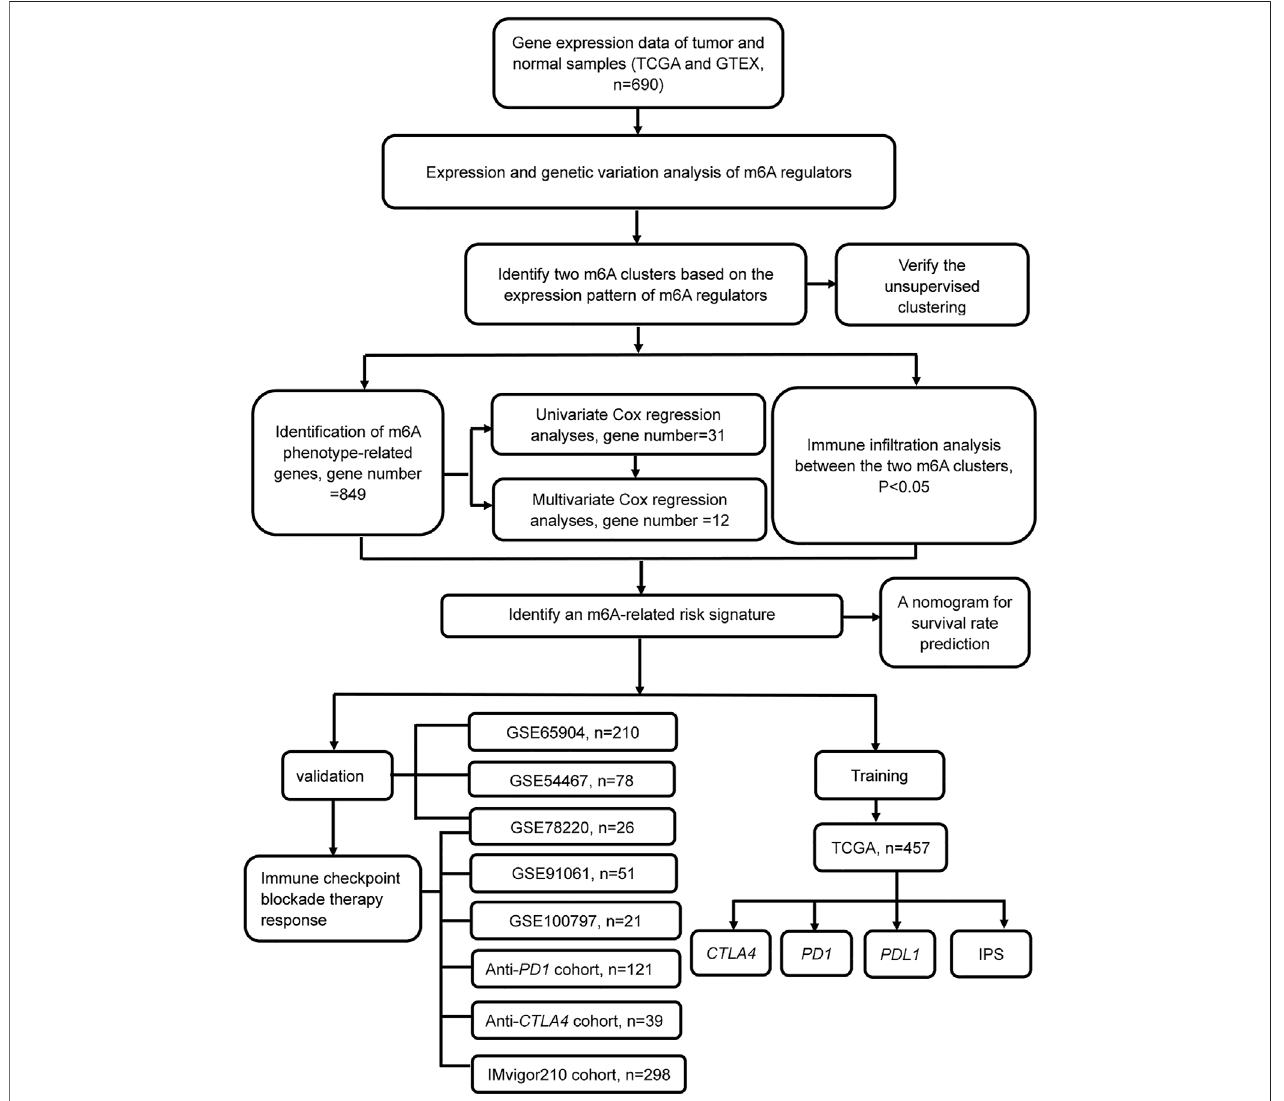
FIGURE 1 | Flowchart of the article. Patients with survival information were selected for this study.